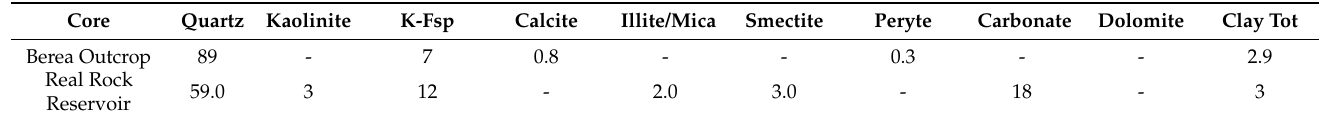
Table 2. Mineral composition of the core material used in this work. Data reported in weight